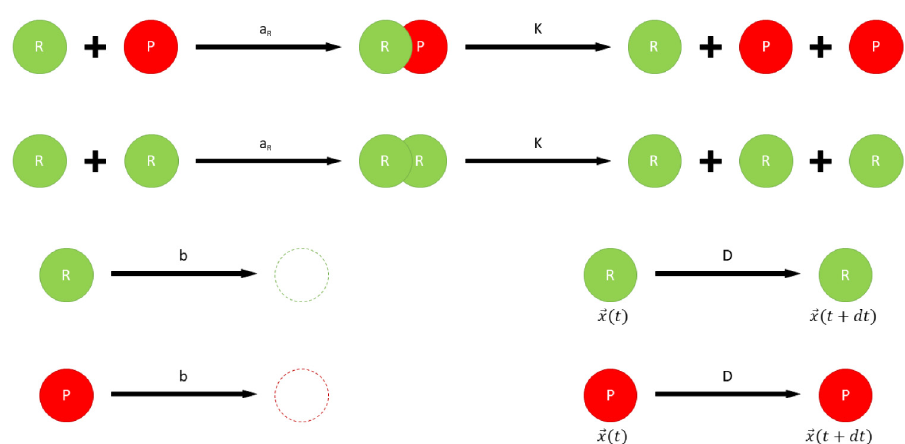
Fig 1. All interactions allowed in the simulation. Replicase (R) can form a complex with other replicase (R) or with parasite (P) at a rate. A replicase-replicase (RR) or replicase-parasite (RP) complex can produce new entity (replicase R in a case of RR and a parasite in the situation of RP) at rate K . Parasites and replicases can move at rate D and decay at rate b . Vector ~ x ð t Þ denotes the agent’s position and vector ~ x ð t þ dt Þ denotes its position in the next